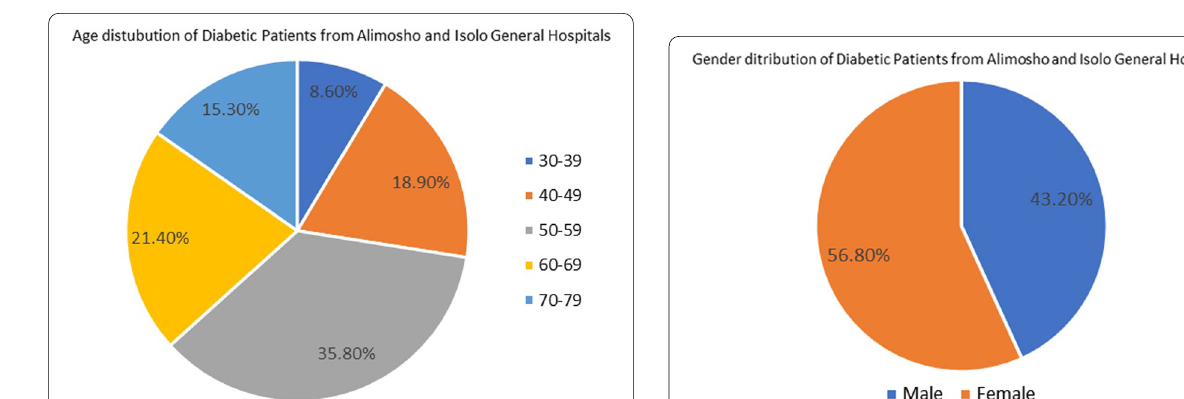
Fig. 1 Frequency of age distribution of diabetic patients in Alimosho and Isolo General Hospitals